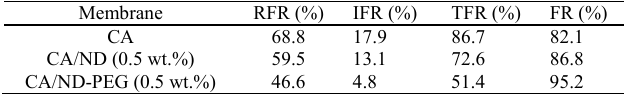
Table 5. Fouling parameters of membranes during BSA filtration.